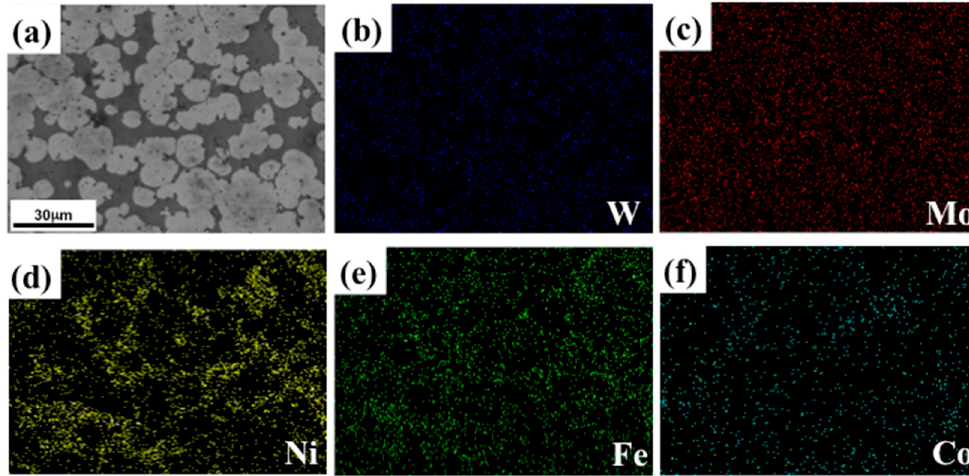
Figure 7. The EDS mapping of the W3Mo model alloy; ( a ) SEM image, ( b ) W map, ( c ) Mo map, ( d ) Ni map, ( e ) Fe map, and ( f ) Co map. Table 2. The relative densities of the W-Mo-Ni-Fe-Co model alloys (%). Model